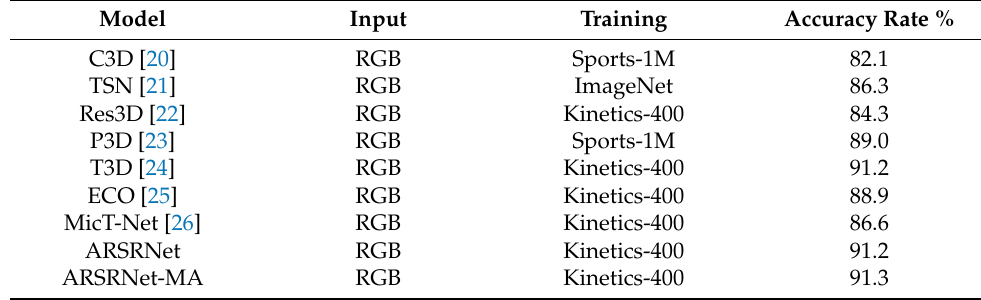
Table 8. Recognition accuracy of behavior recognition networks on UCF101 dataset.